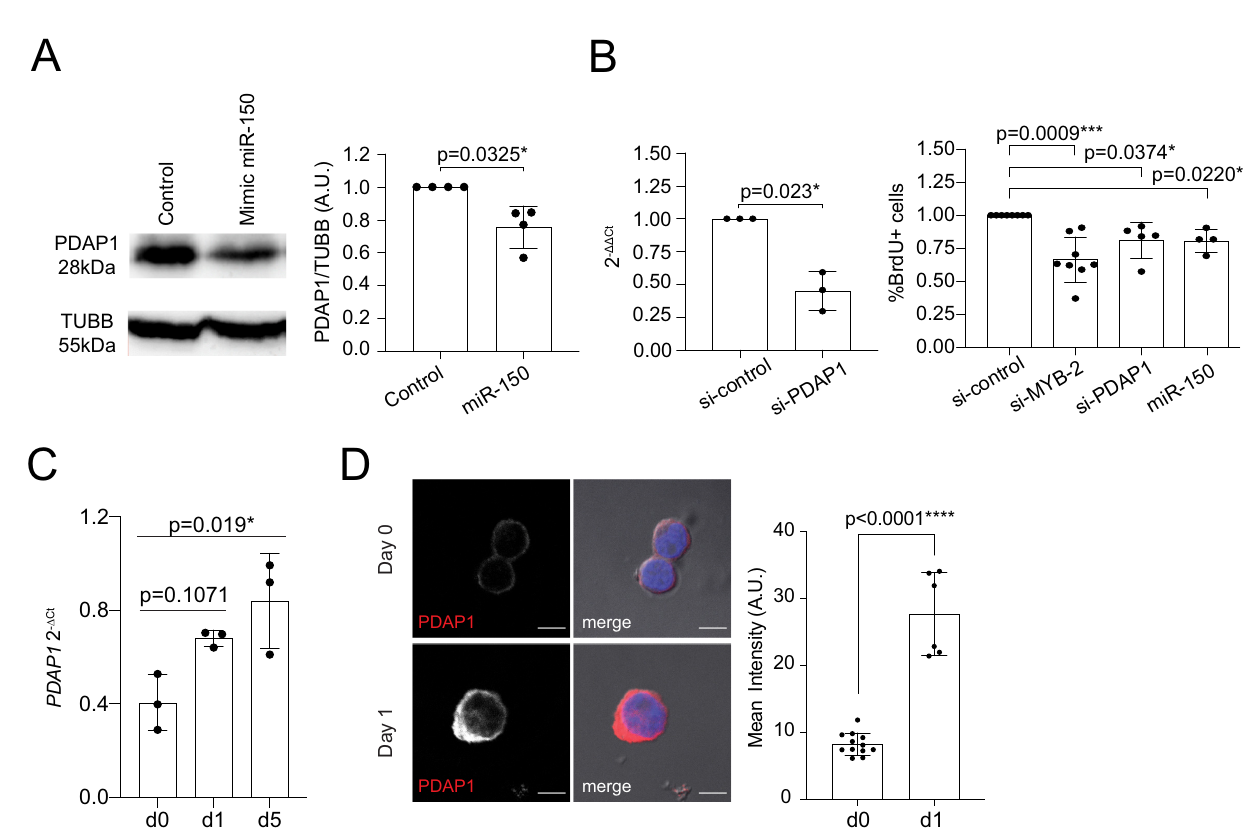
Fig 3. PDAP1 regulates T-cell proliferation and is up-regulated upon activation. (A) Memory T lymphocytes were transfected with either a miR-150 mimic or control oligonucleotide. Twenty-four hours after transfection, expression of PDAP1 was assessed by western blot. Tubulin was used as loading control. A representative western blot is shown on the left, while the densitometric quantification of independent experiments in shown on the right. N = 4. Mean ± SD. Student t test, 2 tailed, paired. (B) Memory T lymphocytes were transfected with siRNAs targeting either MYB or PDAP1 or with a miR-150 mimic oligonucleotide. The extent of PDAP1 down-regulation was measured by RT-qPCR (left), while cell proliferation was measured by BrdU incorporation assay. N = 3 to 8 independent experiments (each dot represents one donor). Mean ± SD. Student t test, 2 tailed, paired. (C) Memory T lymphocytes were stimulated with plate-bound anti-CD3 and anti-CD28 for the indicated days, followed by RT-qPCR analysis of PDAP1 expression. N = 3 (each dot represents one donor). Mean ± SD. One-way ANOVA. (D) Memory T lymphocytes were stimulated with plate-bound anti-CD3 and anti- CD28 for the indicated days, followed by immunofluorescence for PDAP1. The bar corresponds to 5 μ m. Representative of N = 2 experiments. Right: Quantification of the mean intensity of the PDAP1 signal in individual cells. Mean ± SD. Unpaired t test, 2 tailed. Underlying data can be found in S1 Data. PDAP1, PDGFA-associated protein 1; RT-qPCR, reverse transcription quantitative PCR; siRNA, small interfering RNA.